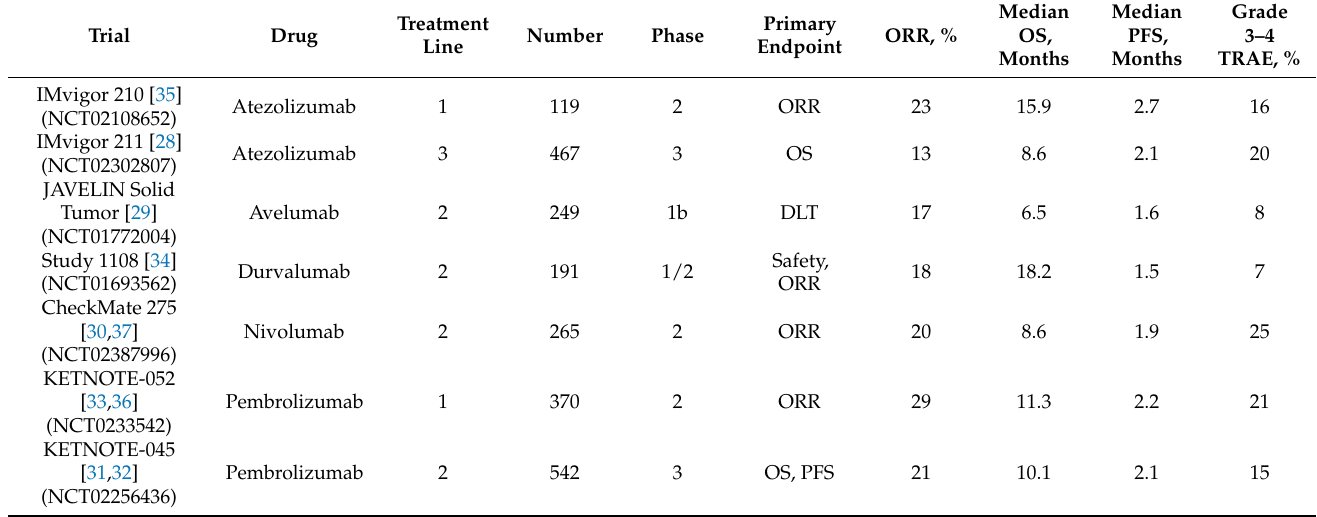
Table 3. Summary of trials for immune checkpoint inhibitors in advanced/metastatic urothelial carcinoma. Trial